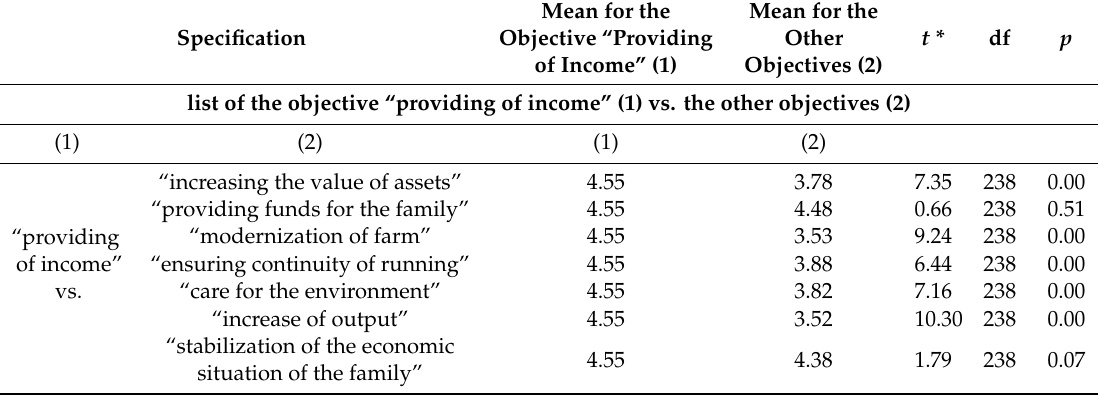
Table 2. Independent samples tests in relation to the assessment of the importance of the objectives of operations of the examined agricultural holdings in the Wielkopolska region (list of the most important economic objectives: “Providing of income” with the other objectives). Mean for the Mean for the t * Other Specification Objective “Providing Objectives (2) of Income” (1)